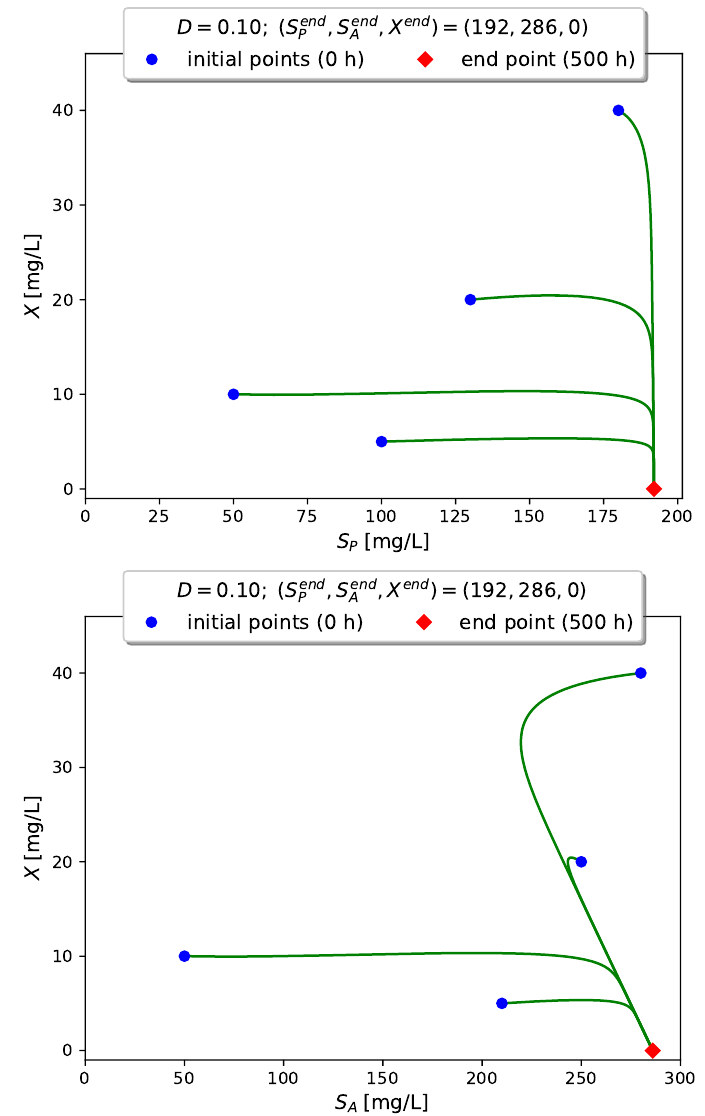
Figure 7. Example 3. Projection of trajectories of system (1)–(3) in different phase planes with several initial